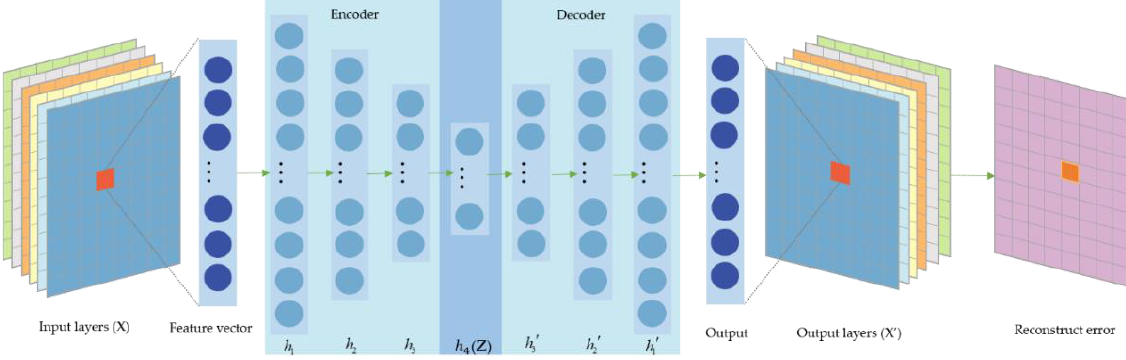
Figure 4. Network structure of DAE.